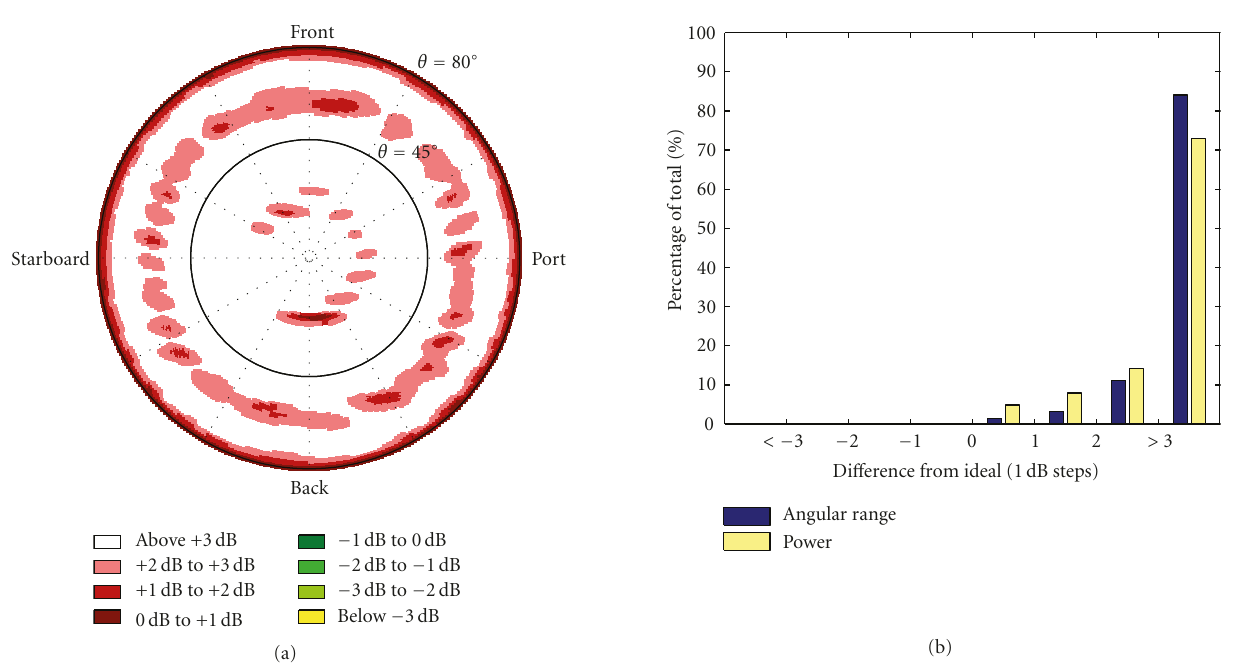
Figure 14: Assessment of 3-turn helical antenna radiation pattern on the gondola normalised to θ = 80 ◦ minima; (a) flattened hemisphere plot of gain comparison to ideal radiation pattern shape, (b) radiation pattern power distribution in relation to ideal radiation pattern shape, from FEKO.